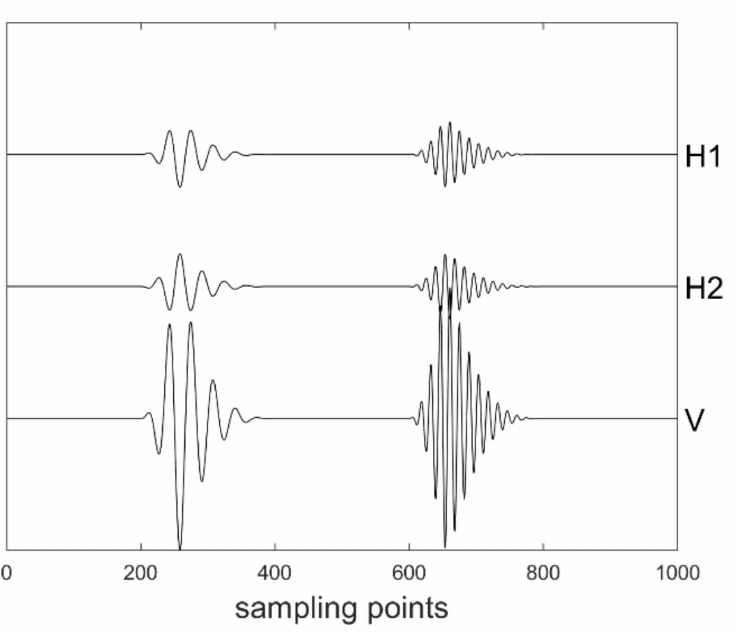
Figure 2. The pure synthetic three-component signal. H1 and H2 denote two horizontal components, V denotes the vertical component.